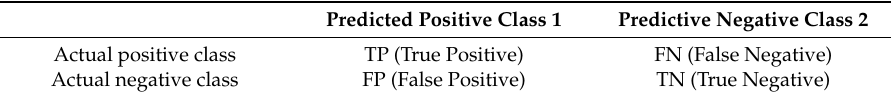
Table 1. Confusion